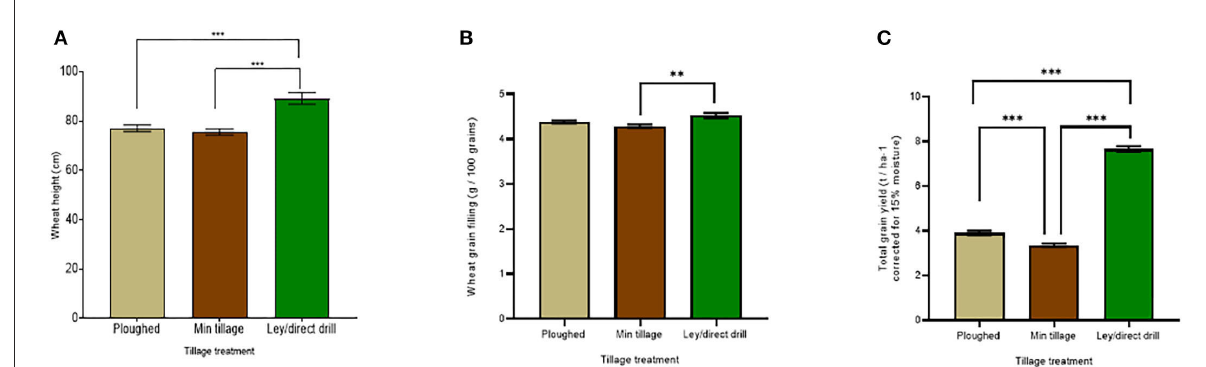
FIGURE2 Ley and tillage effects on wheat yields in the 2018 harvest, averaging across all six genotypes and across the treatments with and without mycorrhiza inoculum added. Bars represent the tillage treatments: ploughed, minimally tilled, and direct drilled into ley. (A) wheat tiller height (cm) (ploughed n = 48 , min tillage n = 52 , and ley n = 24 ), (B) grain-filling (g / 100 grains) (ploughed n = 48 , min tillage n = 48 , ley n = 24 ), and (C) total grain yield (corrected for 15% moisture, t / ha − 1 ) (ploughed n = 48 , min tillage n = 47 , and ley n = 24 ). The error bars show ± 1 SE. Results of Tukey’s HSD test results of significant differences are shown ( * p = 0.05; ** p = 0.001; *** p < 0.0001)